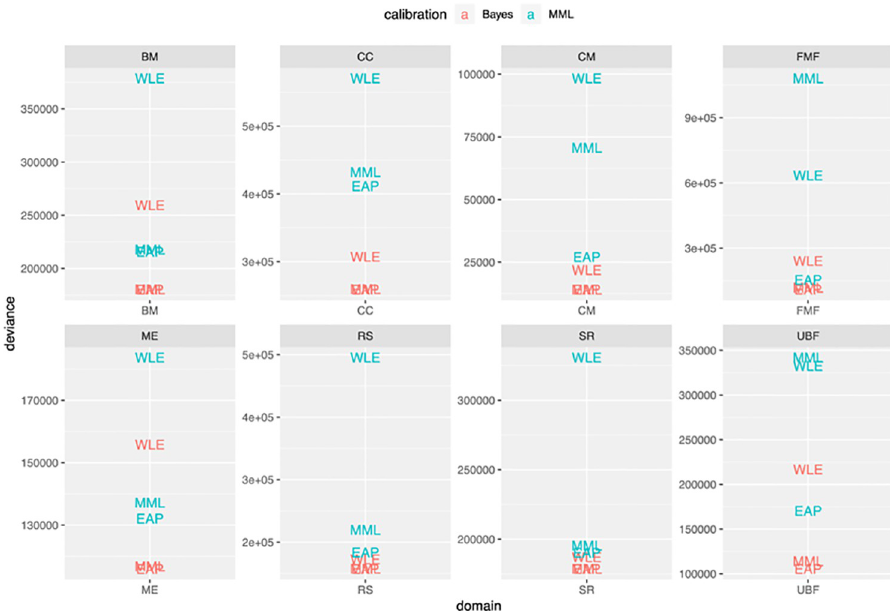
Fig 4. Out-of-sample out-of-subpopulation comparison of calibration and scoring choices for the 8 domains of the WD-FAB (lower is better). The deviance measure is given in Eq 7. These are computed on a control group that was neither used nor intended for use in calibrating the WD-FAB.